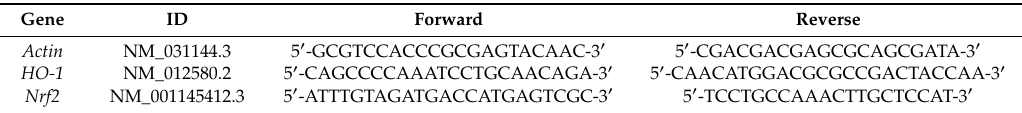
Table 4. Sequences of rat primers